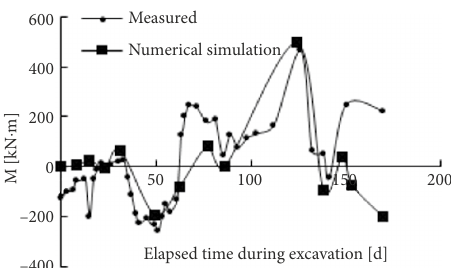
Figure 12. Comparison of the bending moments at monitoring points (5)–(E)